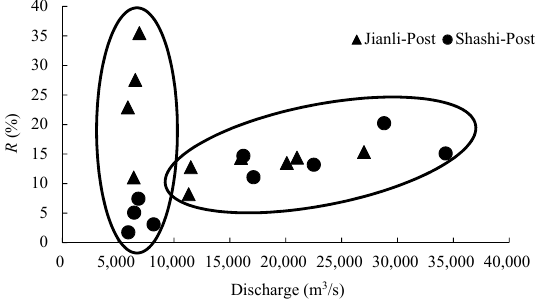
Figure 9. Deviation ratio of sediment transport rate by data measured after TGD dam operation. The two ellipses indicate non-flood season and flood season, respectively. R = contribution ratio of the